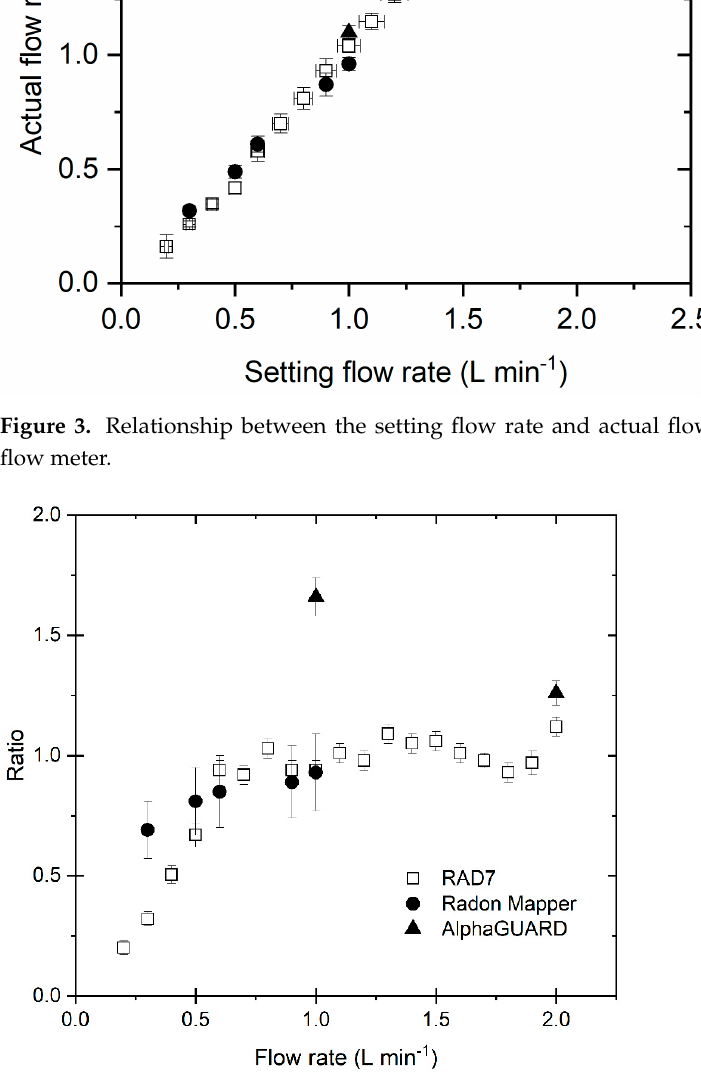
Figure 4. Relationship between the setting flow rate and the measured ratio. The ratio is defined as the thoron concentration measured by each monitor divided by the reference value. The uncertainties are expressed as an expanded uncertainty (i.e., k = 2). The reference value is defined as the thoron concentration measured by the grab sampling method with the AB-5 and the scintillation cell.